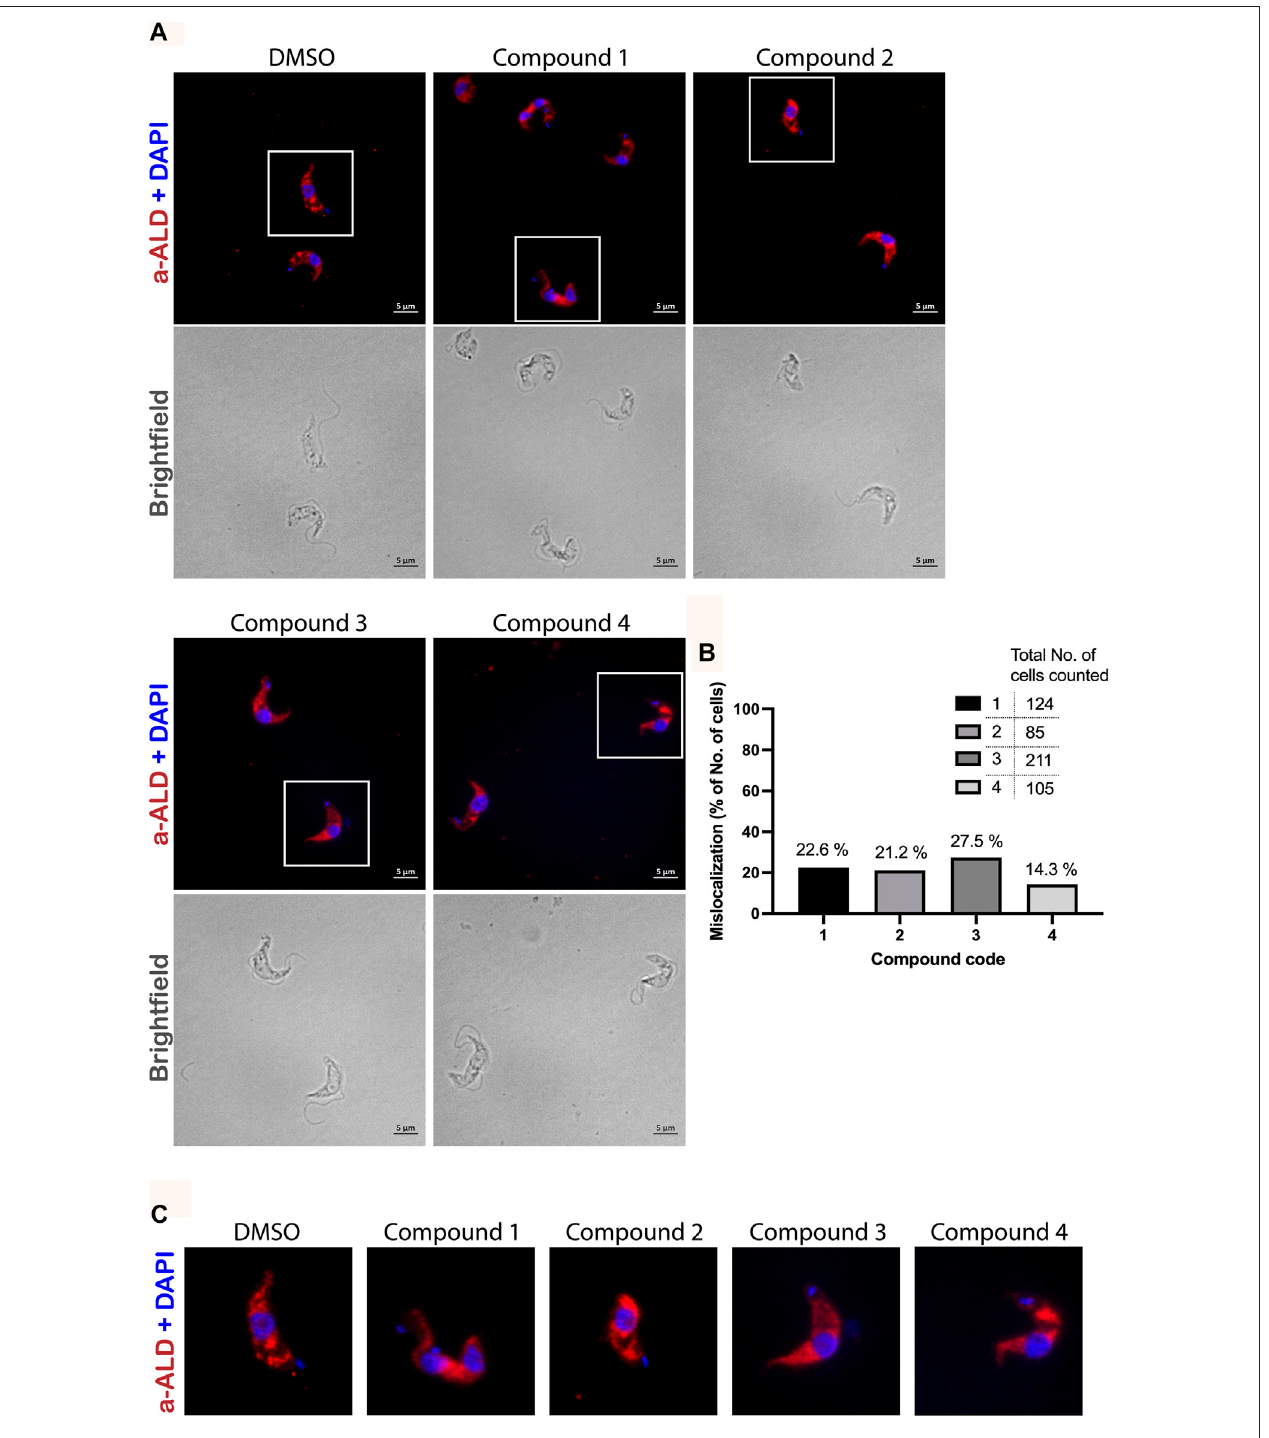
FIGURE 7 | Immuno fl uorescence microscopy analysis of the effect of PEX3 – PEX19 inhibitors on glycosomes. (A) Wild-type T. brucei bloodstream form parasites were treated with DMSO or inhibitors for 24 h. Compound-treated cultures with 50% of the growth rate compared to the DMSO control were fi xed followed by staining with anti-TbAldolase primary antibody and Alexa Fluor 594 – labeled secondary antibody. (a-ALD, red; DAPI-labeled nucleus and kinetoplast, blue). Corresponding bright- fi eldimages areshown inthe lowerpanels. Apunctate pattern indicatedthelocalizationofaldolase inglycosomes(DMSO). Differentlevels ofmislocalization ofaldolasetothecytosolwerenoticedineachofthecompound-treatedsamples. (B) Numbersofcellsshowingaldolasemislocalizationwerecounted.About20% – 30% of cells treated with compounds 1 , 2 , and 3 and 15% of compound 4 treated cells showed aldolase mislocalized to the cytosol. (C) Images of individual cells, which are marked by white boxes in (A) , were 2X magni fi ed for better illustration.